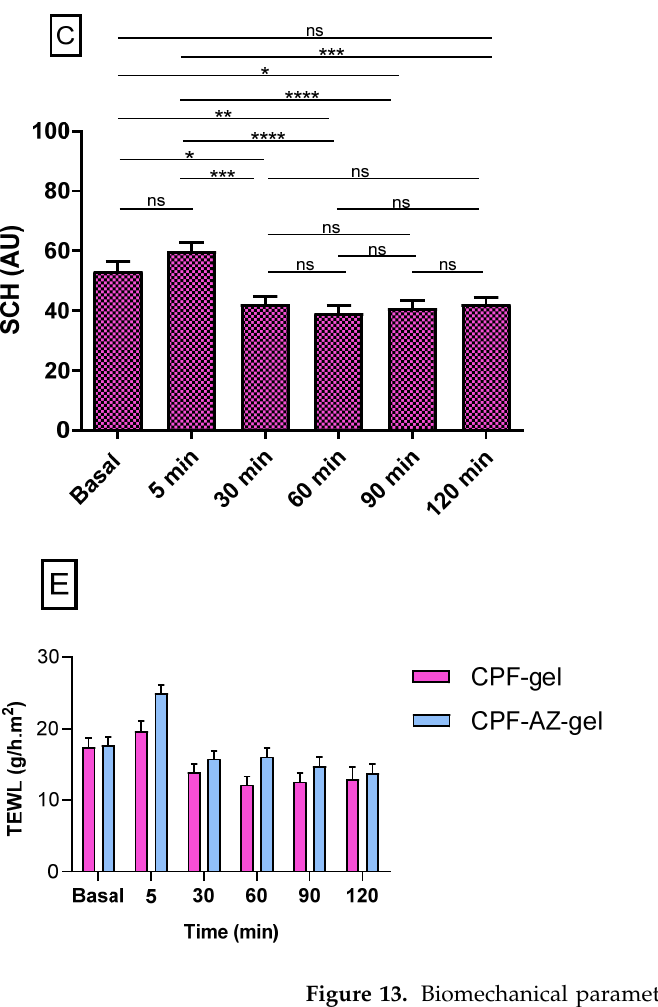
Figure 13. Biomechanical parameters evolution in human volunteers was monitored before the application of the formulations (basal) and 5 min, 30 min, 60 min, 90 min, and 120 min post-application. ( A , B ) TEWL of CPF-gel and CPF-AZ-gel, respectively, expressed as g/h × m 2 . ( C , D ) the SCH of CPF- gel and CPF-AZ-gel respectively expressed as arbitrary units (AU). Significant statistical differences: * p < 0.05, ** p < 0.01, *** p < 0.001, **** p < 0.0001, ns = non-significant. ( E ) Comparison of the evolution of the TEWL between both formulas: CPF-gel and CPF-AZ-gel. ( F ) Comparison of the evolution of the SCH between both formulas: CPF-gel and CPF-AZ-gel. Each value represents the mean ± SD (n =